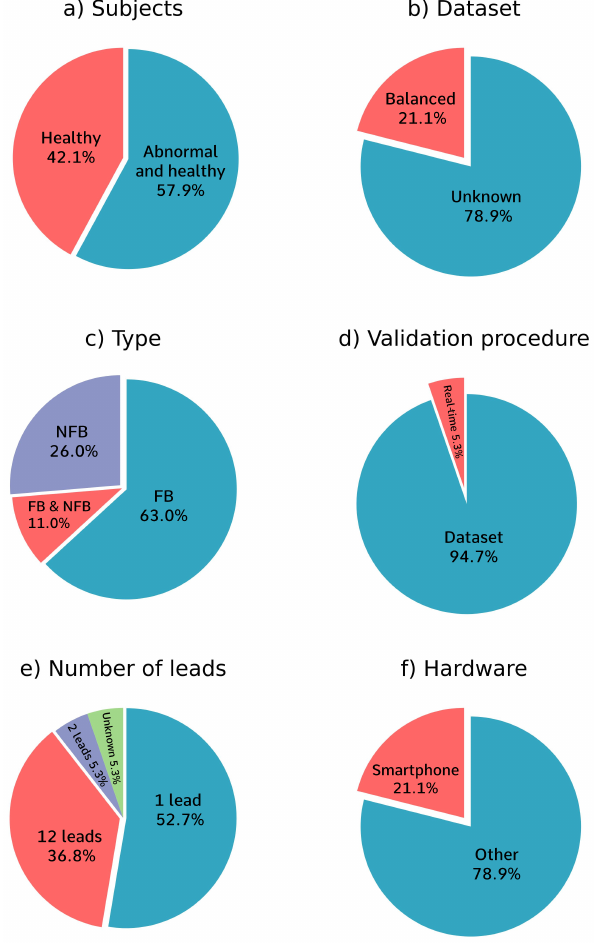
Figure 4. Pie charts of the analysis methods used. ( a ) 57.9% of the papers used data from both healthy and diseased subjects for training and 42.1% only used data from healthy subjects without heart conditions for training. ( b ) 21.1% of the papers balanced their data; 78.9% of the papers did not mention whether they used data balancing techniques. ( c ) 63.0% of the papers used an FB (feature-based, machine learning) algorithm, 26.0% of papers used an NFB (non-feature-based, deep learning) algorithm, and 11.0% of the papers used a combination of both FB and NFB algorithms. ( d ) Only one paper validated the algorithm that was created in real-time with test subjects. ( e ) 47.4% of the papers used 1-lead data, 36.8% of the papers used 12-lead data, one paper used 2-lead data, one paper used both 1-lead and 5-lead data, and one paper did not mention the number of leads used. ( f ) 21.1% of the papers mentioned that their algorithm is meant to run on a